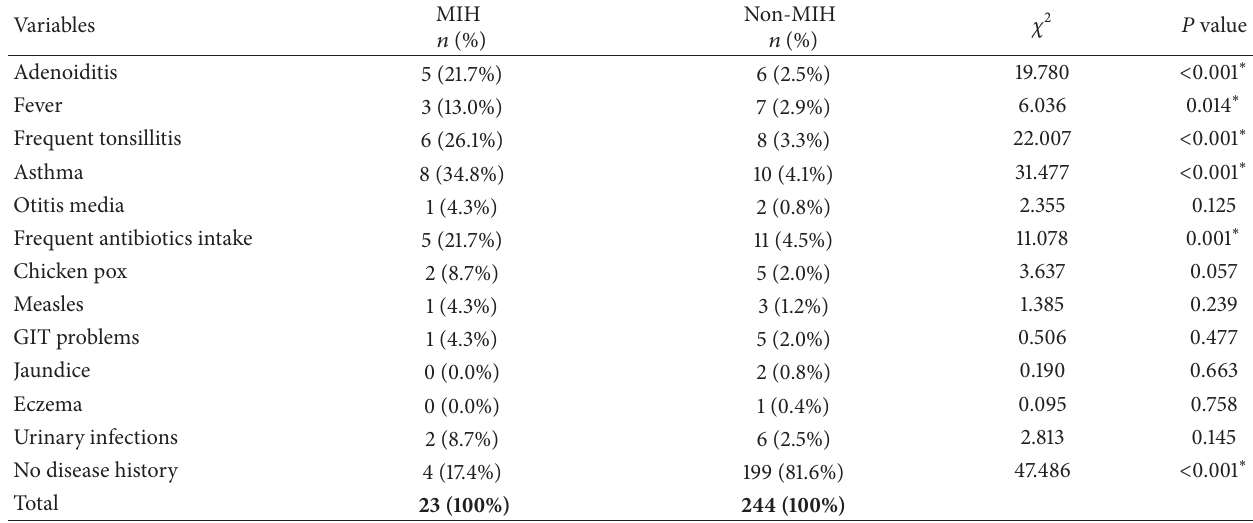
Table 5: The association between health problems during the first four years of life and prevalence of MIH. Variables